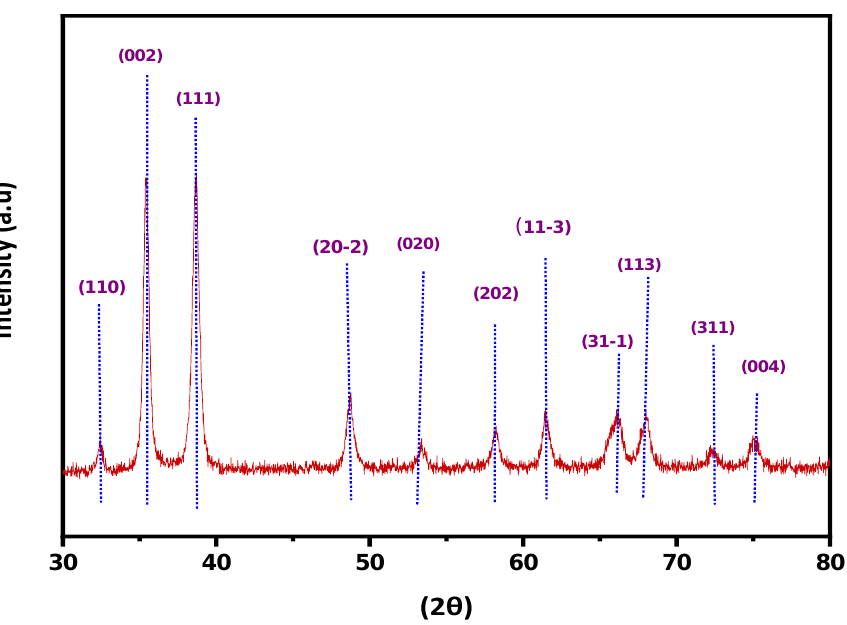
Figure 3. XRD pattern of bio-synthesized CuO nanoplates.